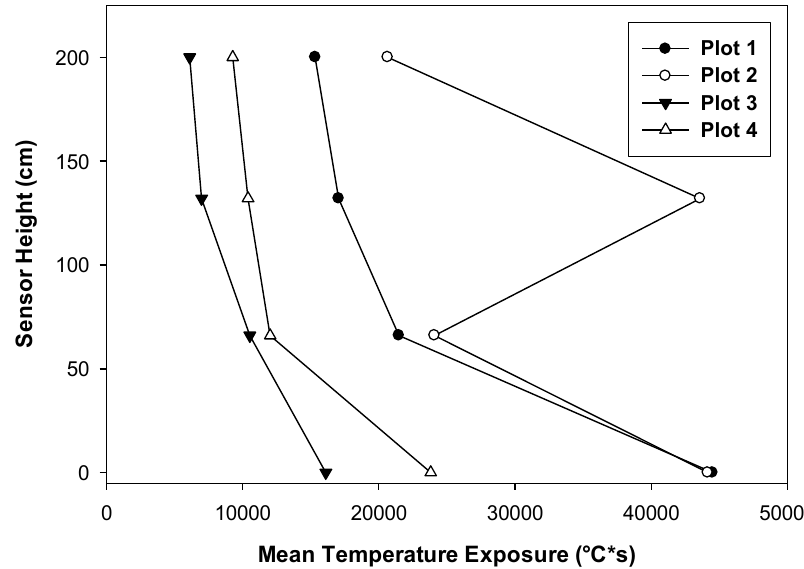
Figure 7. Horizontal and vertical distribution of mean temperature exposure (MTE) in different plots with advance regeneration.